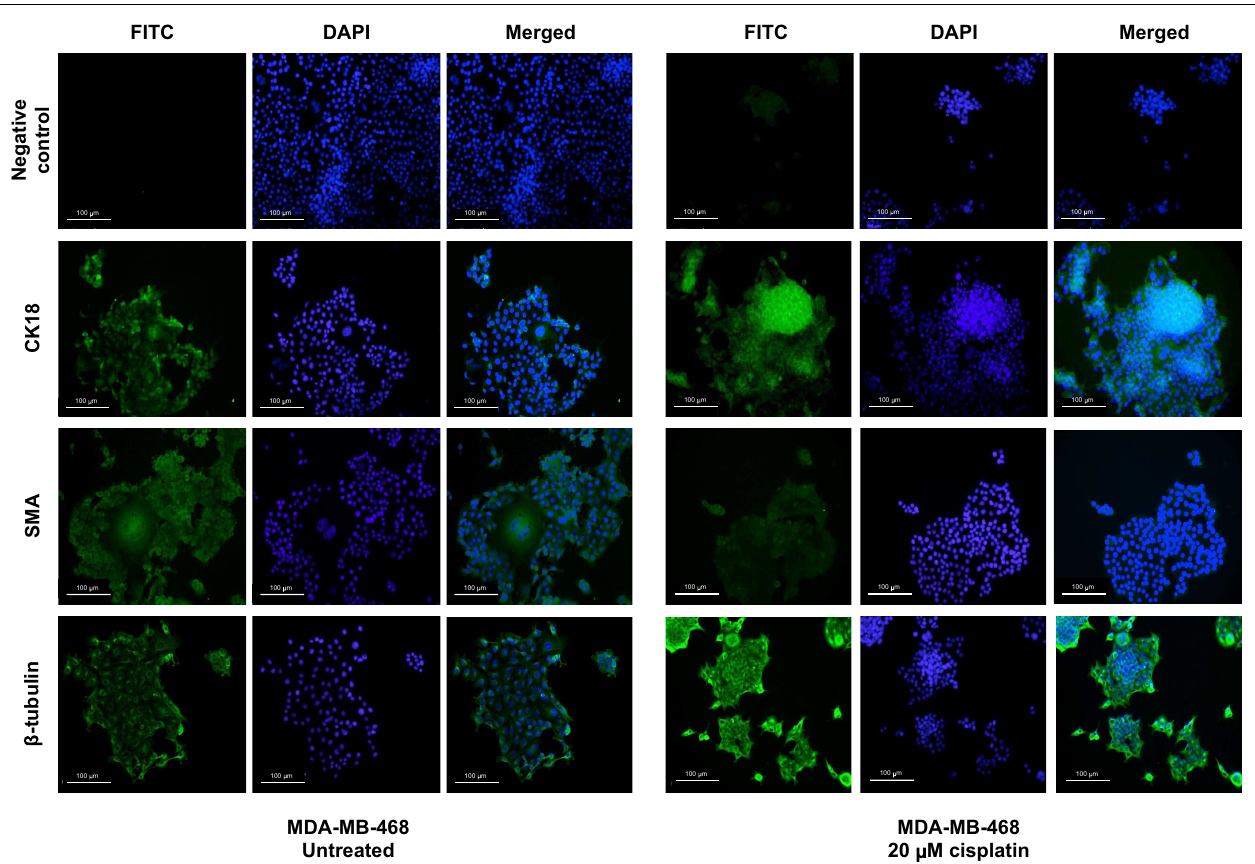
FIGURE 4 | Cisplatin influences expression of differentiation markers in MDA-MB-468 . Differentiation markers CK18 and β -tubulin were up-regulated upon treatment with 20 µ M cisplatin in MDA-MB-468 cells. DAPI nuclear stain was used to stain the nucleus (blue), whilst all other markers are shown in green. Scale bars: 100 µ